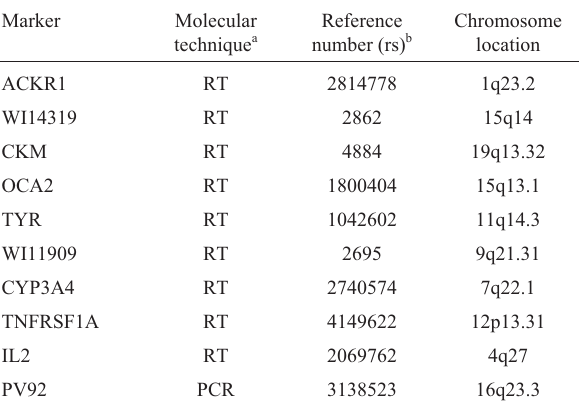
Table 1 - Ancestry Informative Markers used in this study. Marker